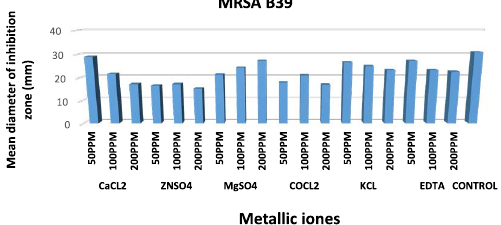
Fig. 2-f. Antimicrobial activity of mixture of ethyl acetate extracts of P. plebeium and E.hirta against MRSA B39 in relation to different vitamins